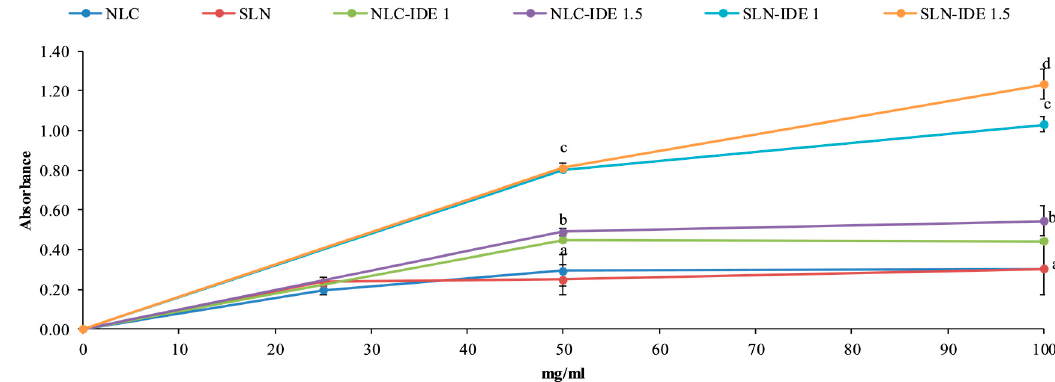
Figure 3. Reducing power of SLN, NLC, and samples loaded with 1% and 1.5% w/w of idebenone (IDE). The letters b, c, and d indicate a significant difference ( p < 0.05) between samples loaded with different concentrations of IDE and the samples of unloaded NLC and SLN (indicated with the letter a). NLC = unloaded nanostructured lipid carrier; SLN = unloaded solid lipid nanoparticles; NLC-IDE 1 = NLC loaded with IDE 1% w/w; SLN-IDE 1 = SLN loaded with IDE 1% w/w; NLC-IDE 1.5 = NLC loaded with IDE 1.5% w/w; SLN-IDE 1.5 = SLN loaded with IDE 1.5% w/w.